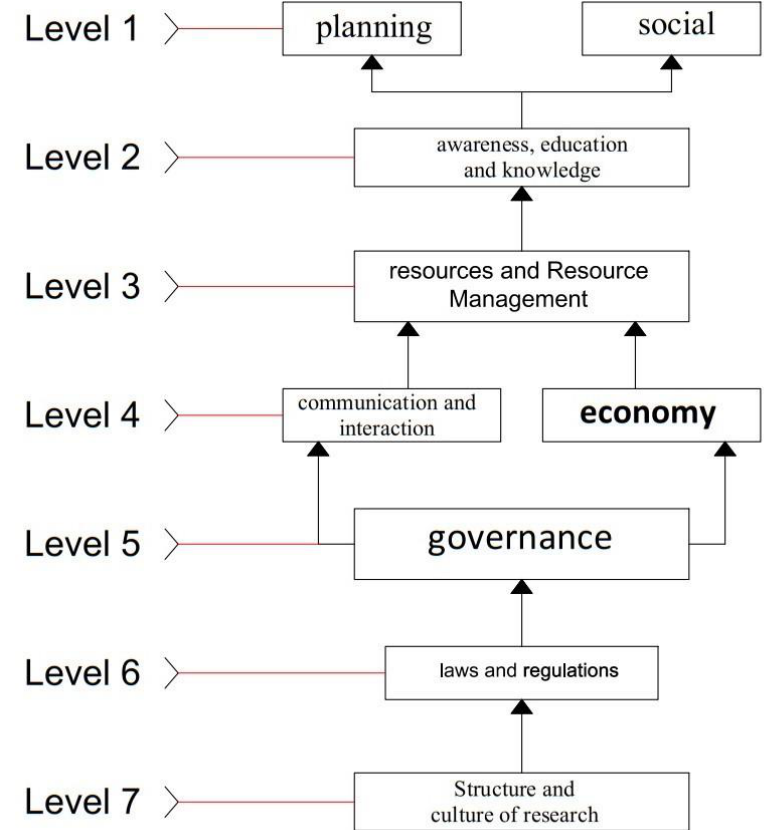
Figure6. Figure 6. ISM based framework for barriers to climate change adaptation in Tehran’s urban management.